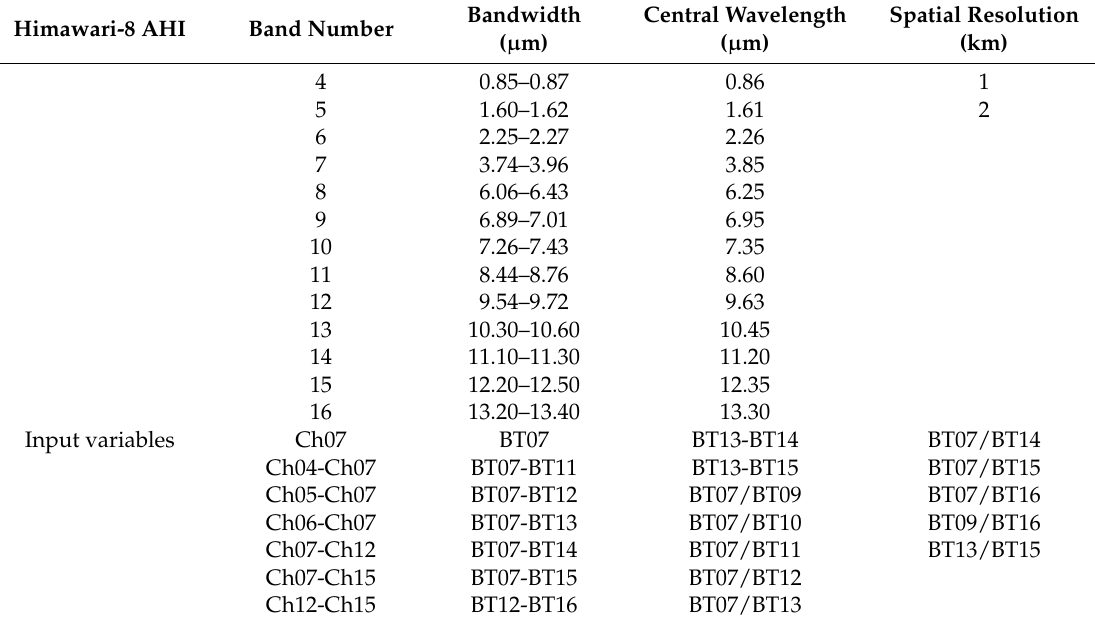
Table 2. Himawari-8 AHI bands and variables used in machine learning modeling in this study (Ch is the radiance of each band and BT is the brightness temperature of each band). Himawari-8 AHI